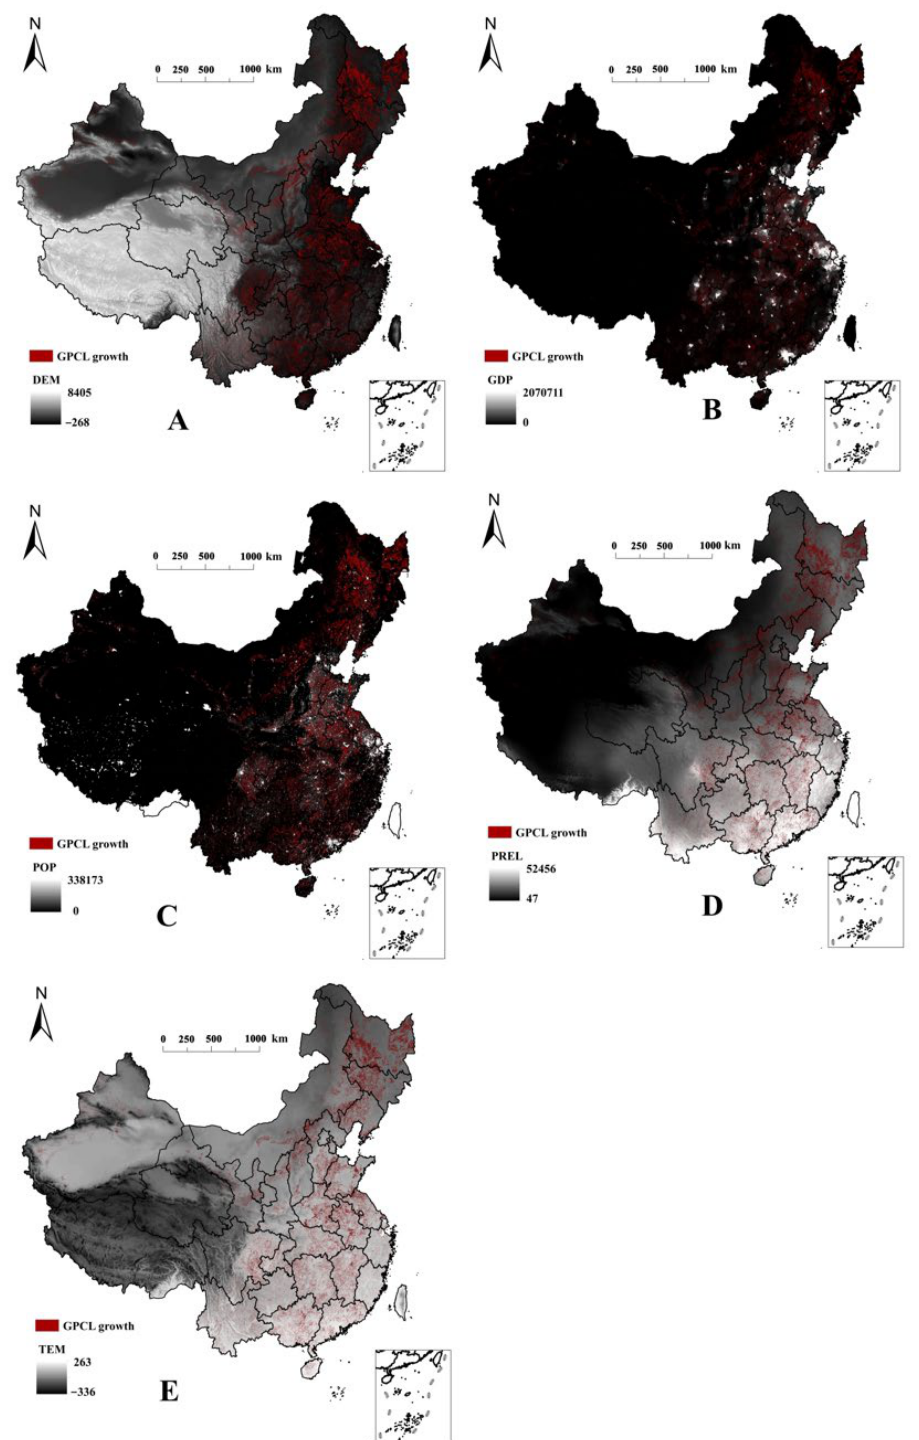
Figure 4. Superposition of grain-producing cultivated land (GPCL) expanding plaques and major contributors. ( A ) Superposition of grain-producing cultivated land (GPCL) expanding plaques and DEM. ( B ) Superposition of grain-producing cultivated land (GPCL) expanding plaques and GDP. ( C ) Superposition of grain-producing cultivated land (GPCL) expanding plaques and population (POP). ( D ) Superposition of grain-producing cultivated land (GPCL) expanding plaques and annual precipitation (PREL). ( E ) Superposition of grain-producing cultivated land (GPCL) expanding plaques and annual mean temperature